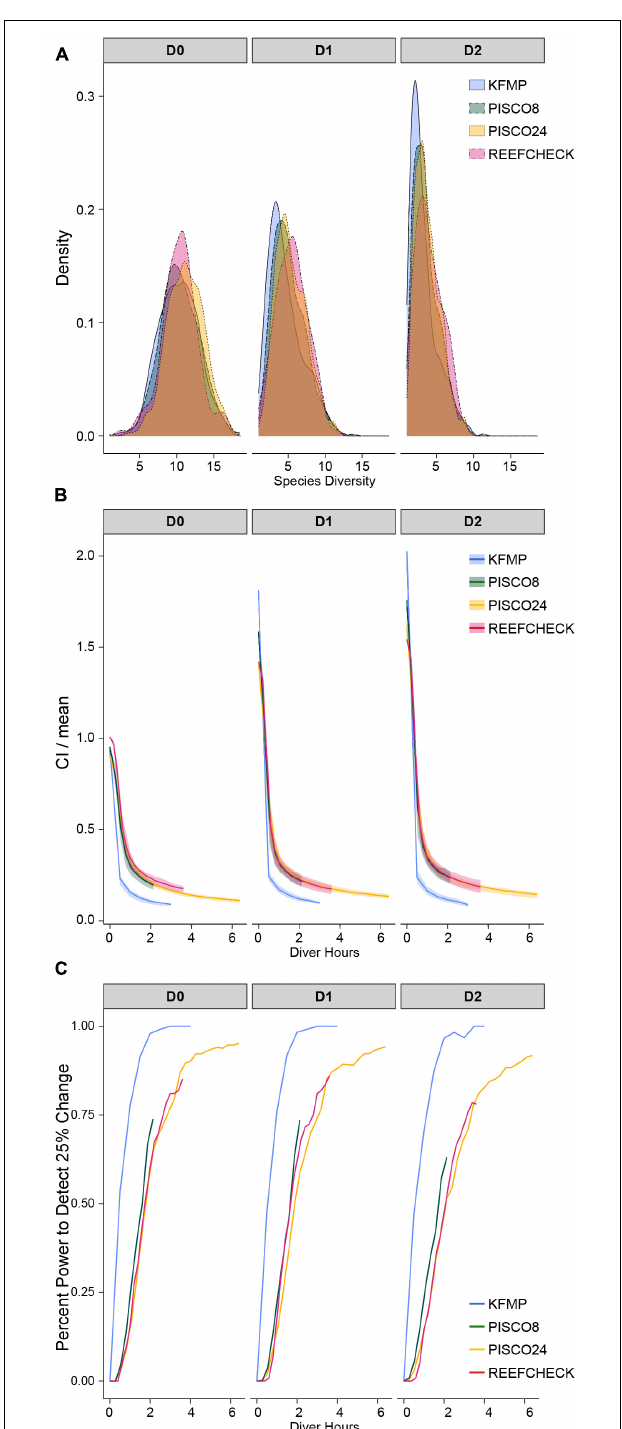
FIGURE 3 | (A) Distribution of species diversity estimates across sampling events; (B) confidence interval curves as a function of sampling effort calculated from sampling events at sites with typical fish density (40–60th percentile for each program) as a function of sampling effort; (C) probability of obtaining confidence that biodiversity is within 25% of the estimated value as a function of sampling effort. All for the first three Hill numbers calculated from the full sampling events including the full taxa list for each monitoring